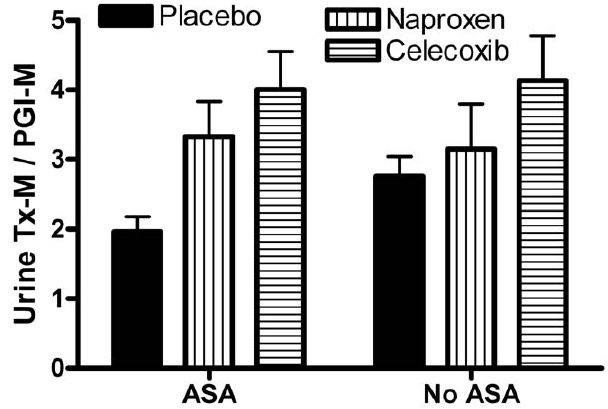
Figure 1. Urine Tx-M/PGI-M ratio in compliant ADAPT partic- ipants who self-reported ASA use was analyzed by